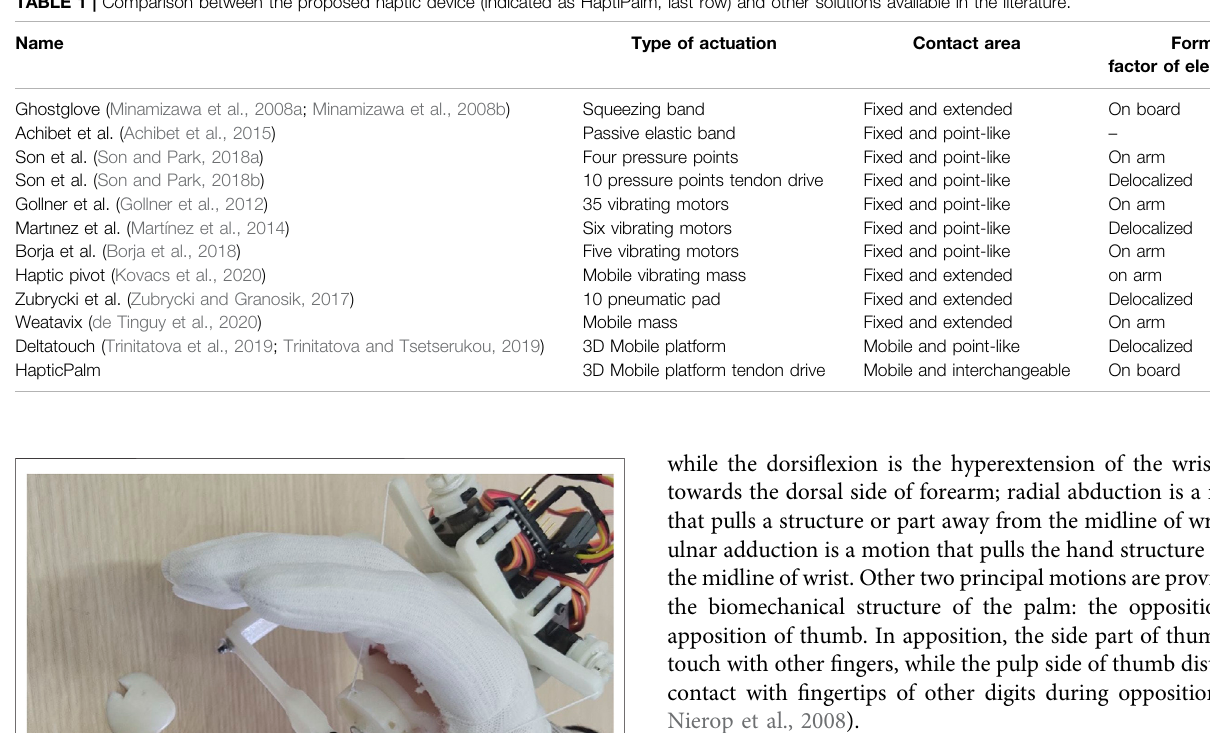
TABLE 1 | Comparison between the proposed haptic device (indicated as HaptiPalm, last row) and other solutions available in the literature.